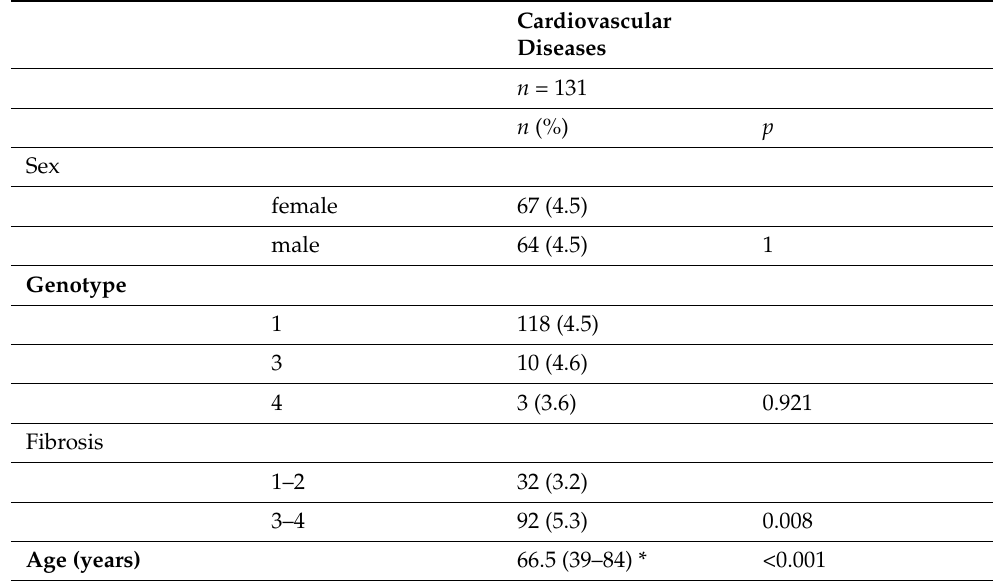
Table 4. The characteristics of patients—cardiovascular diseases—in relation to the all study